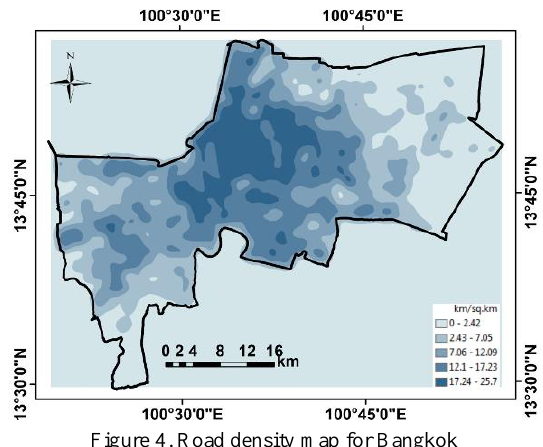
Figure 4. Road density map for